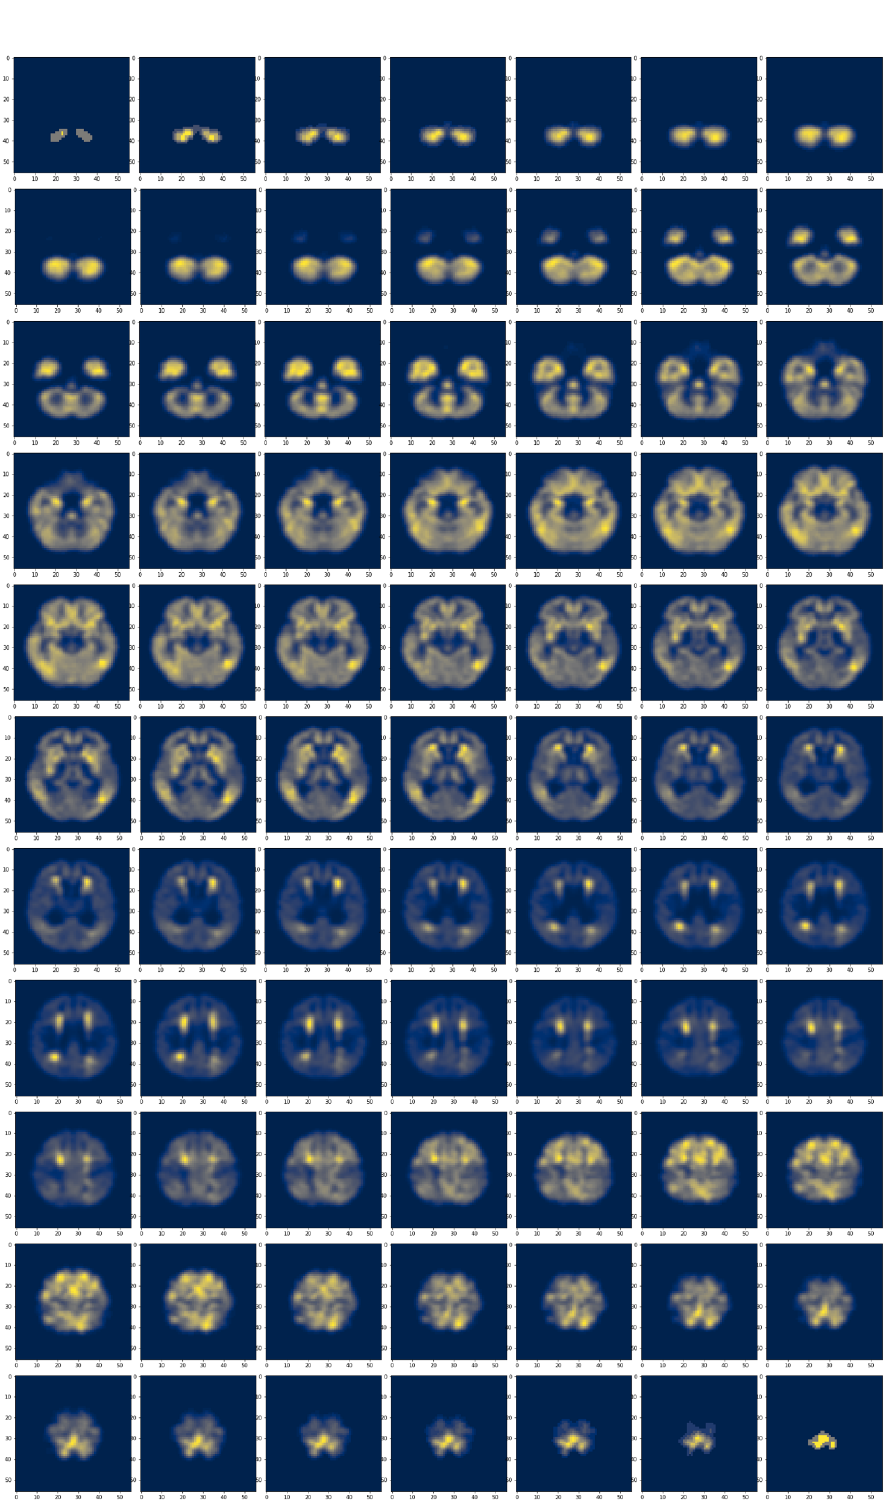
Figure A3. The global attention feature map was obtained by multiplying the FC layer vector by each pixel in the structural MRI brain slices and measuring the sum of the multiplication per pixel. Next, we normalized the feature map to (0,255) and visualized the maps using the CIVIDIS color map. Finally, we selected the first slice of each time-course to demonstrate various brain morphology across the MRI data